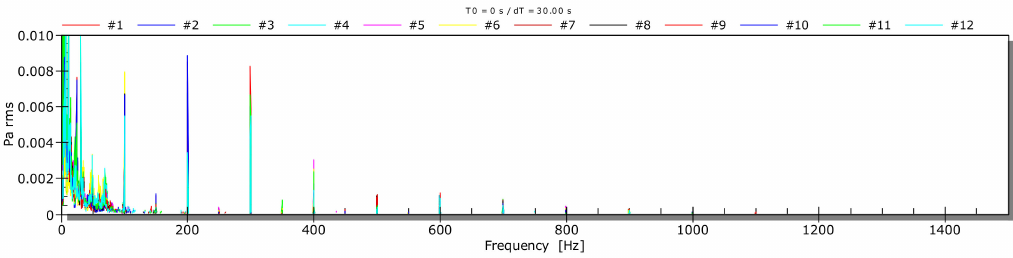
Figure 17. Frequency spectrum of acoustic noise under rated